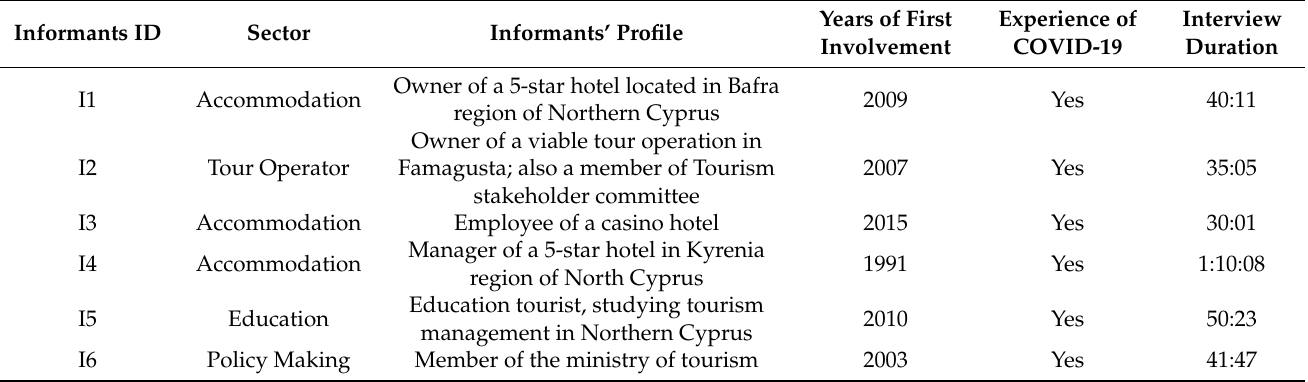
Table 1. Informants Details (n =